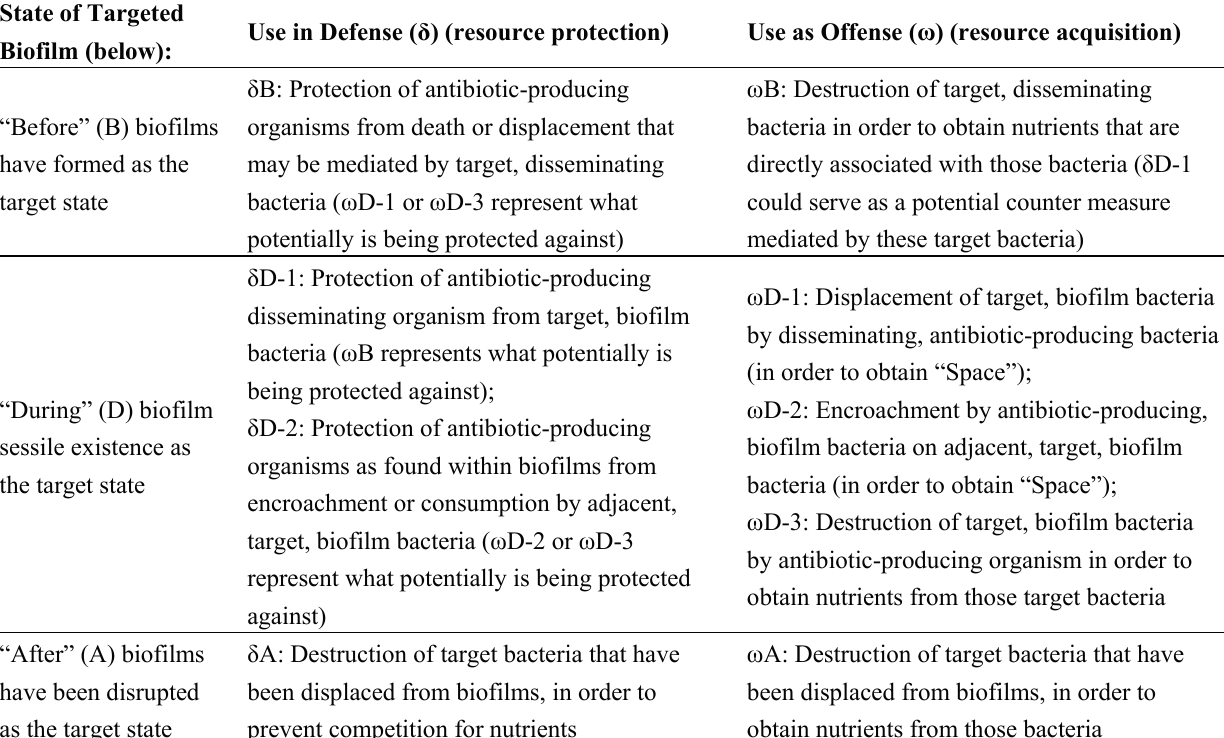
Table 1. Proposed categories of anti-biofilm activity. “Before”, “During”, and “After” refer to the biofilm state of “Target” organisms which are being impacted by antibiotic action. “Use in Defense” and “Use as Offense” refer to the utility of these agents to producers. Note that no reference is made within these categories of the degree to which a biofilm has matured following its initiation; degrees of “During” in other words are not considered. Abbreviations are provided for subsequent reference, e.g., “ δ B” stands for “Defense Before” meaning antibiotic-mediated Defense ( δ ) against disseminating bacteria, thus acting on target bacteria Before (B) they have formed biofilms. Such actions could be mediated, in this case, by either planktonic or biofilm-associated organisms. See also Figure 1 for a graphic